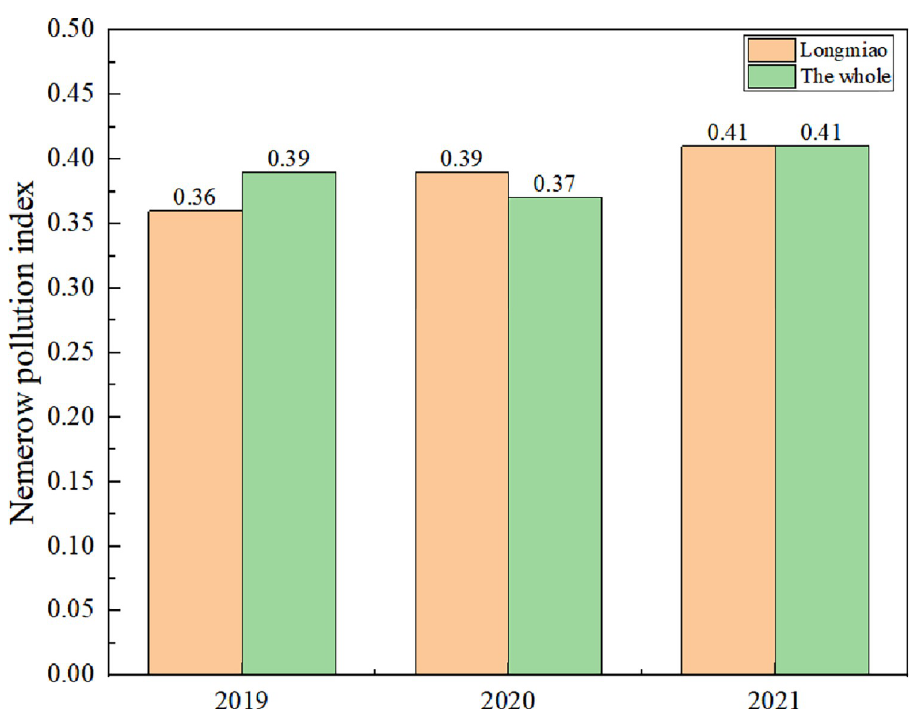
Fig 4. Changes in Nemerow pollution index for the Longmiao and The whole from 2019 to 2021.